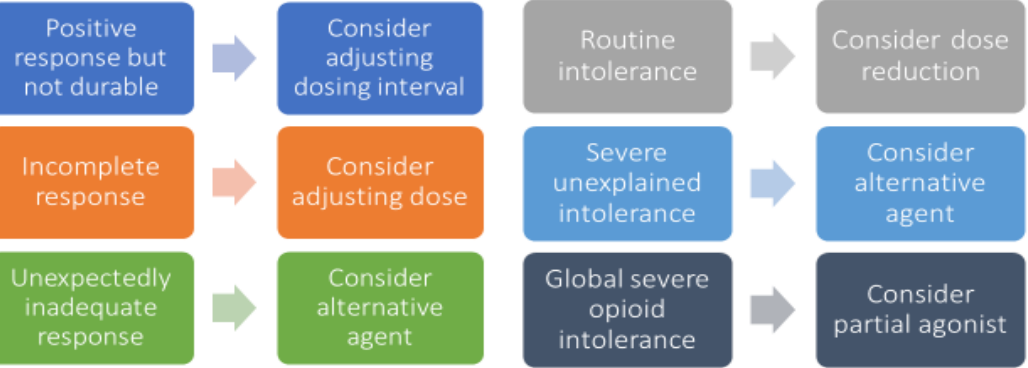
Figure 5. Framework for patient-specific opioid regimen adjustments. Legend: each matching pair of boxes represents a potential scenario for opioid regimen optimization, with a specific issue listed in the left box and the recommended adjustment in the associated right box.